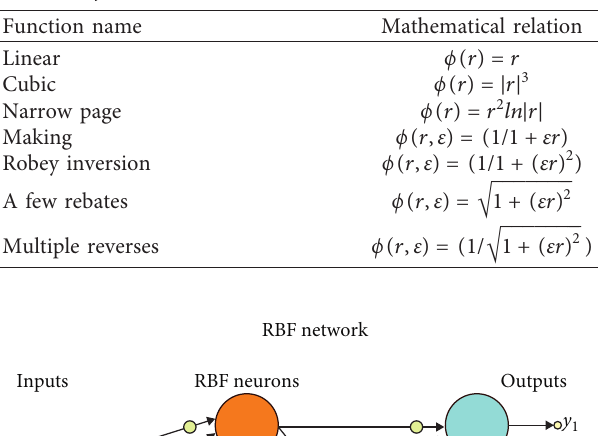
Table 1: Transition functions used in the radial base function ( r � ‖ x − r j ‖‖ ).